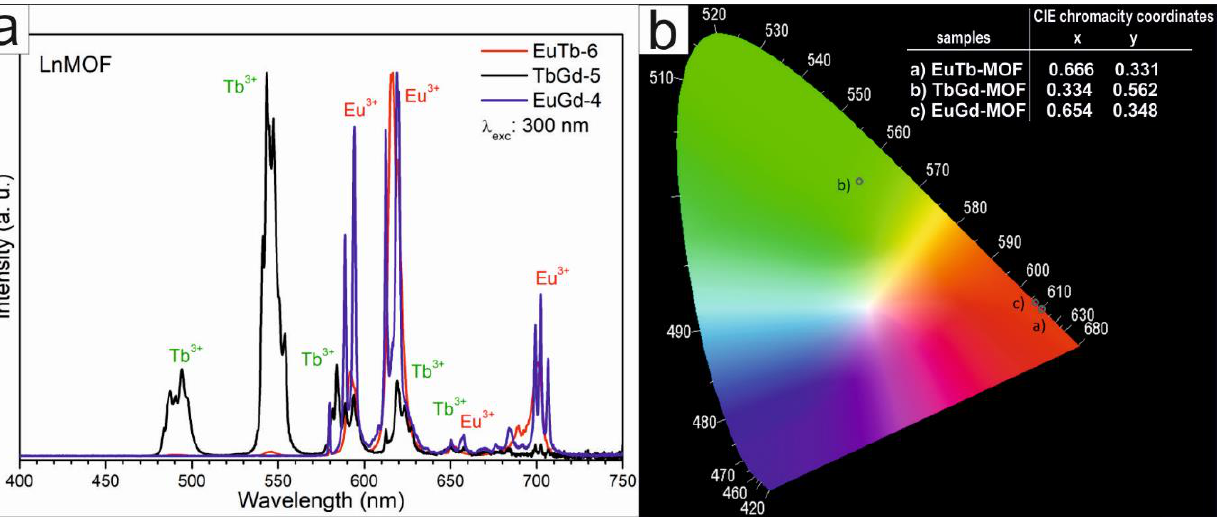
Figure 8. (a ) Emission spectra and ( b ) CIE chromaticity diagrams of bimetallic lanthanide MOFs.